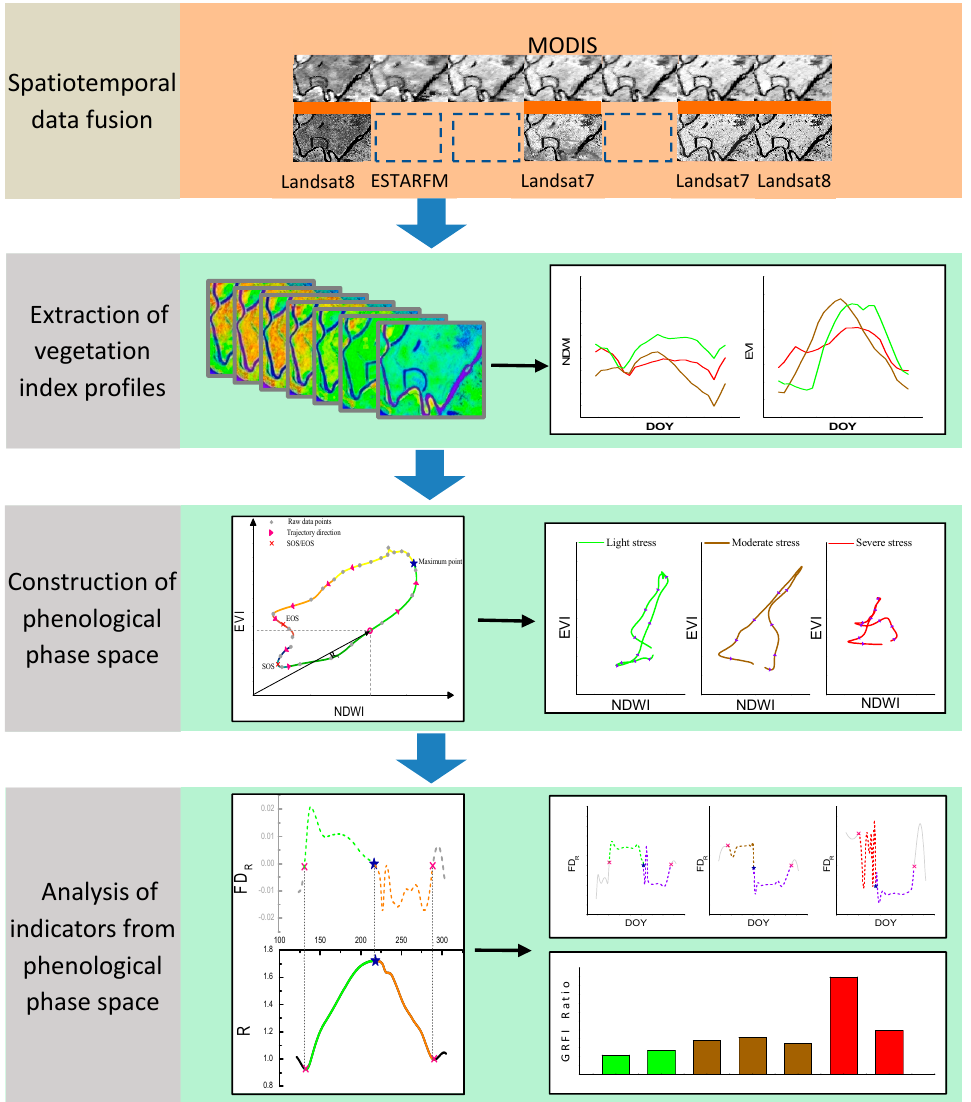
Figure 2. Flow chart of monitoring heavy metal stress of rice using phenological phase space and temporal profile analysis (ESTARFM represents enhanced spatial and temporal adaptive reflectance fusion model. NDWI represents the normalized difference water index. NDVI represents the normalized difference vegetation index. EVI represents the enhanced vegetation index. DOY represents the day of the year. R represents the distance from the data point of the i th day to the origin of the phase space. FD R represents the first derivative of R. GRFI represents the rice growth rate fluctuation. The GRFI Ratio represents the ratio of the rice growth rate fluctuation.